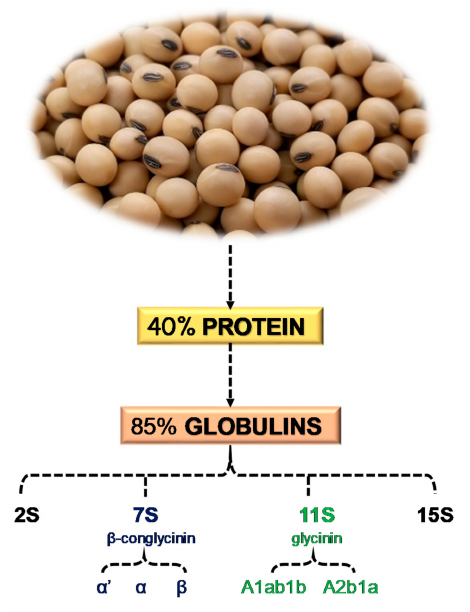
Figure 3. Summary of the main components of soybean proteins